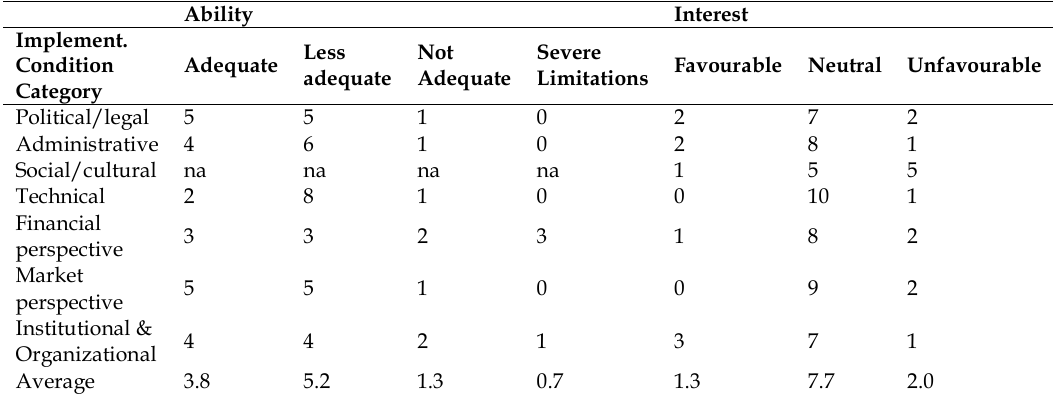
Table 6. Summary of scores on implementation conditions (no. of countries) Ability Interest